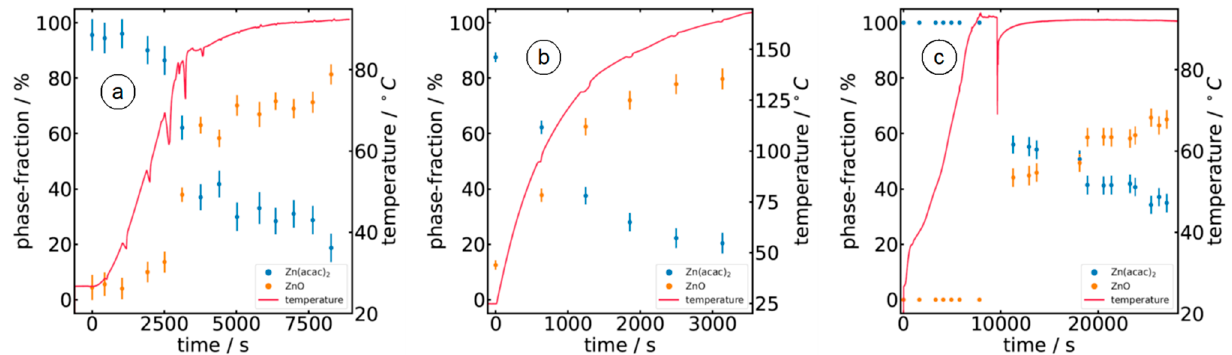
Figure 6. Results of linear combination fits of the EXAFS data measured in the course of the reaction in ( a ) Zn(acac) 2 solution in 10 − 3 M NaOH (sample A); ( b ) Zn(acac) 2 solution in 1-octanol (sample O); and ( c ) Zn(acac) 2 solution in distilled water (sample W), respectively. Reference spectra of crystalline ZnO and Zn(acac) 2 were used for the fits.